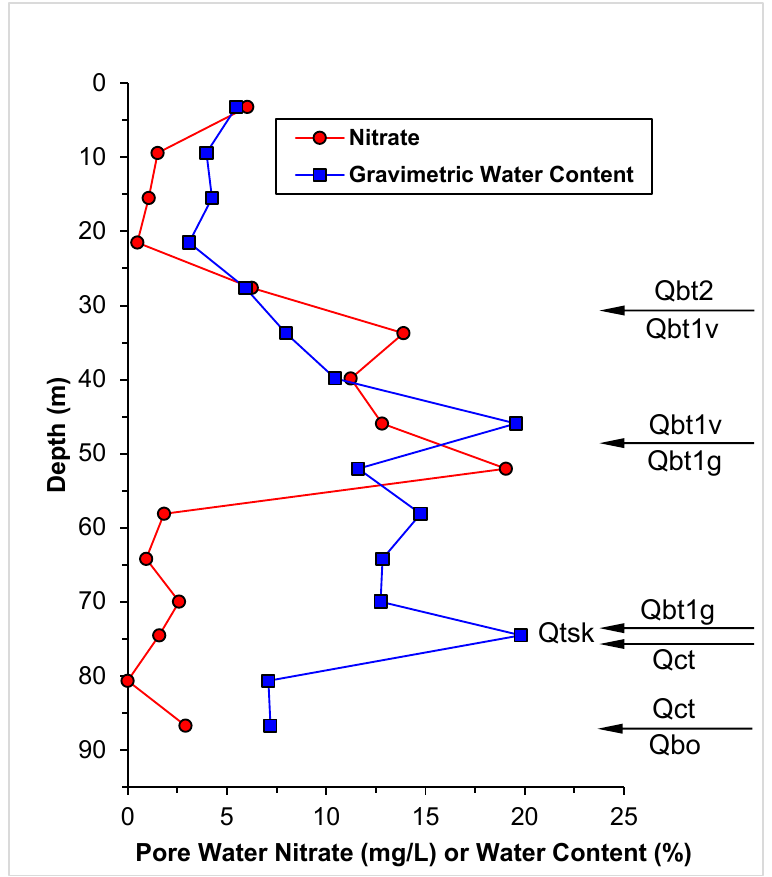
Figure 11. Comparison of Borehole 7 nitrate and gravimetric water content values.